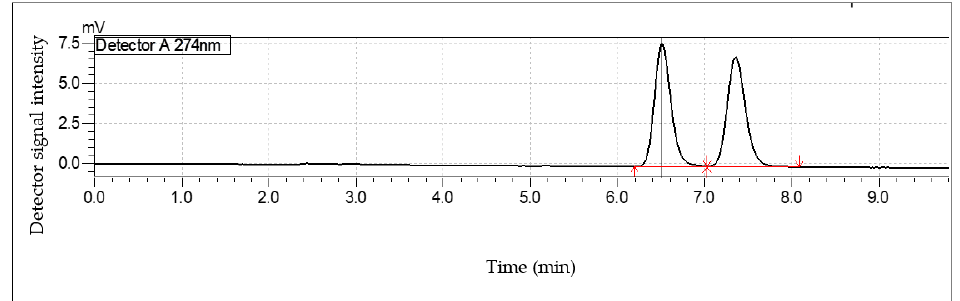
Figure 3. HPLC chromatogram of (±)-cloprostenol was separated into its two enantiomers using the method outlined by Kalikova et al. [22].